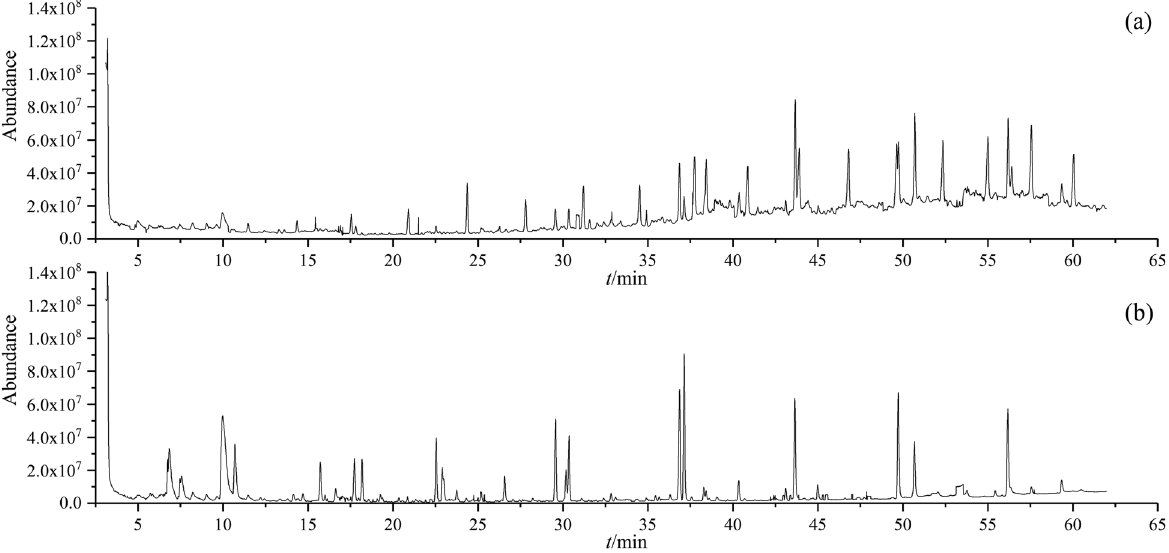
Figure 3: Total ion current of volatile composition analyzed on V. auraria. ( a ) The petroleum ether part of the fresh V. auraria ; ( b ) The petroleum ether part of the dried V. auraria